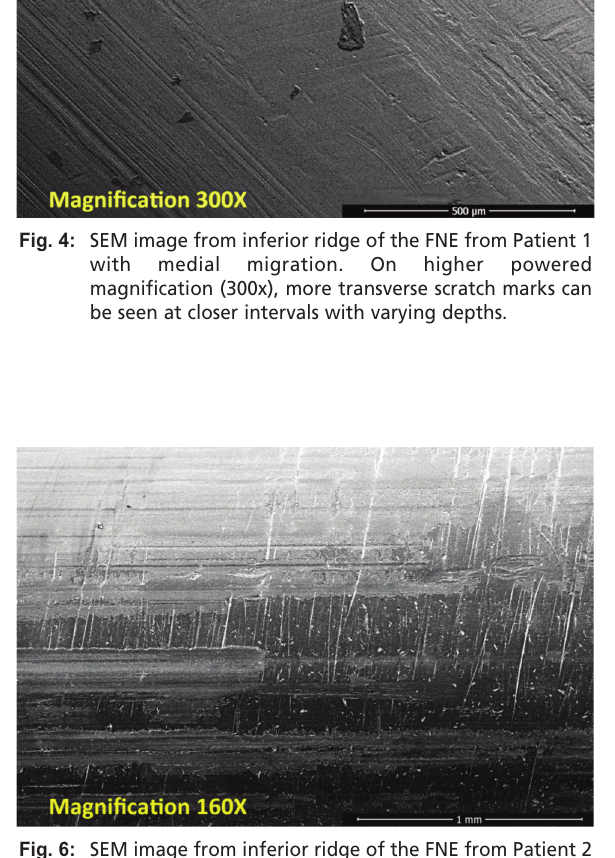
Light microscopy image from inferior ridge of the FNE Fig. 5: from Patient 1 with medial migration showing both transverse scratch marks and longitudinal scratch marks (black dots were placed as markers to facilitate identification of the location of the transverse scratch marks on the FNE).